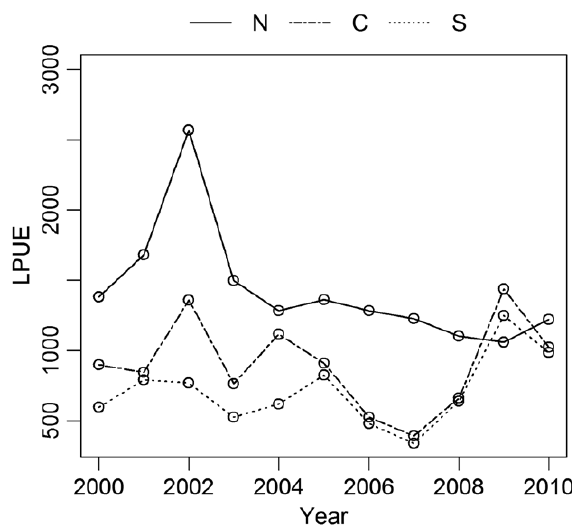
Fig. 4. – Anchovy LPUE during the spawning season (from May to Oc- tober) for each sector during the years 2000-2010. N, Northern sector; C, Central sector; S, Southern sector.